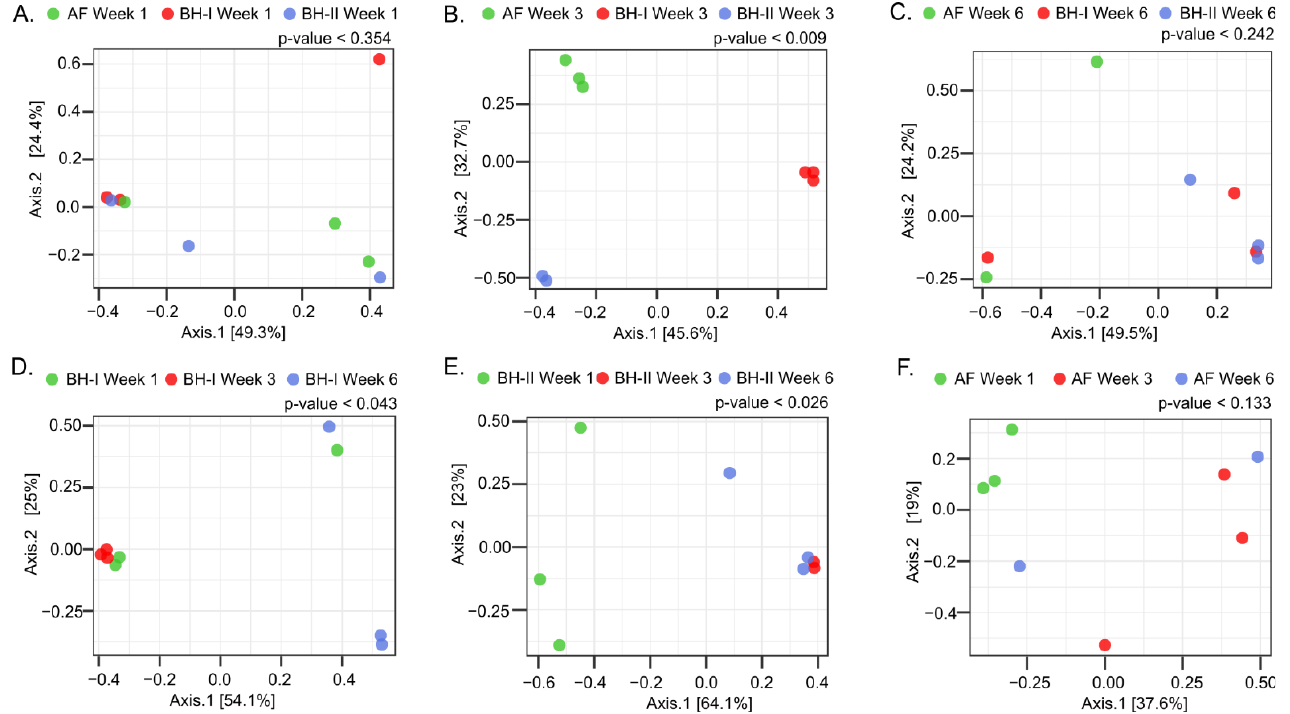
Figure 5. Beta-diversity analysis of tracheal samples. PCoA of samples by time and housing. In the top panel, analysis between housing at week 1 ( A ), week 3 ( B ), and week 6 ( C ). In the bottom panel, analysis over time of sampling on BH-I ( D ), BH-II ( E ), and AF ( F ). The analysis was performed using Bray–Curtis measures of beta diversity. Statistics: PERMANOVA. AF: experimental animal facility, BH: broiler